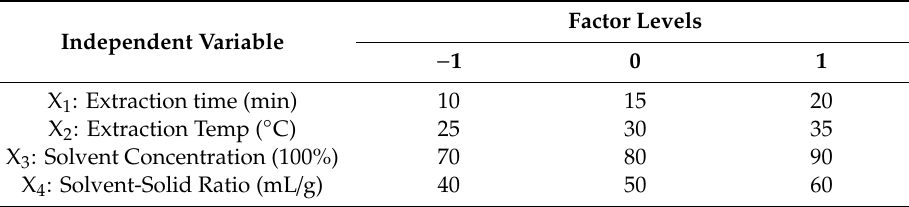
Table 1. Experimental domain of the Box-Behnken